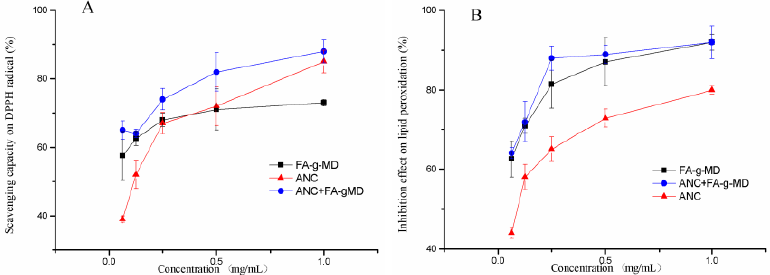
Figure 3. Effects of ANC, FA-g-MD and their combination on inhibiting free radicals. ( A ) DPPH radicals, ( B ) lipid peroxidation. The values are expressed as mean ± SD (n = 3).